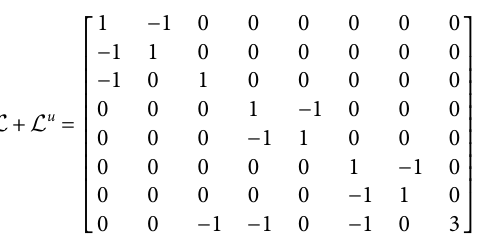
FIGURE 11 | Network routing after topology design of USVs and Laplacian operator after